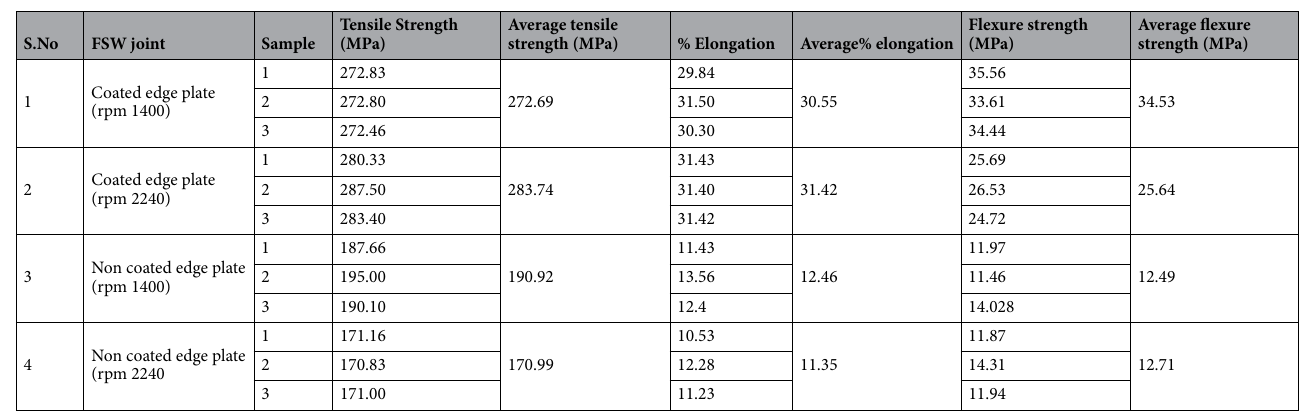
Table 2. Tensile and flexure